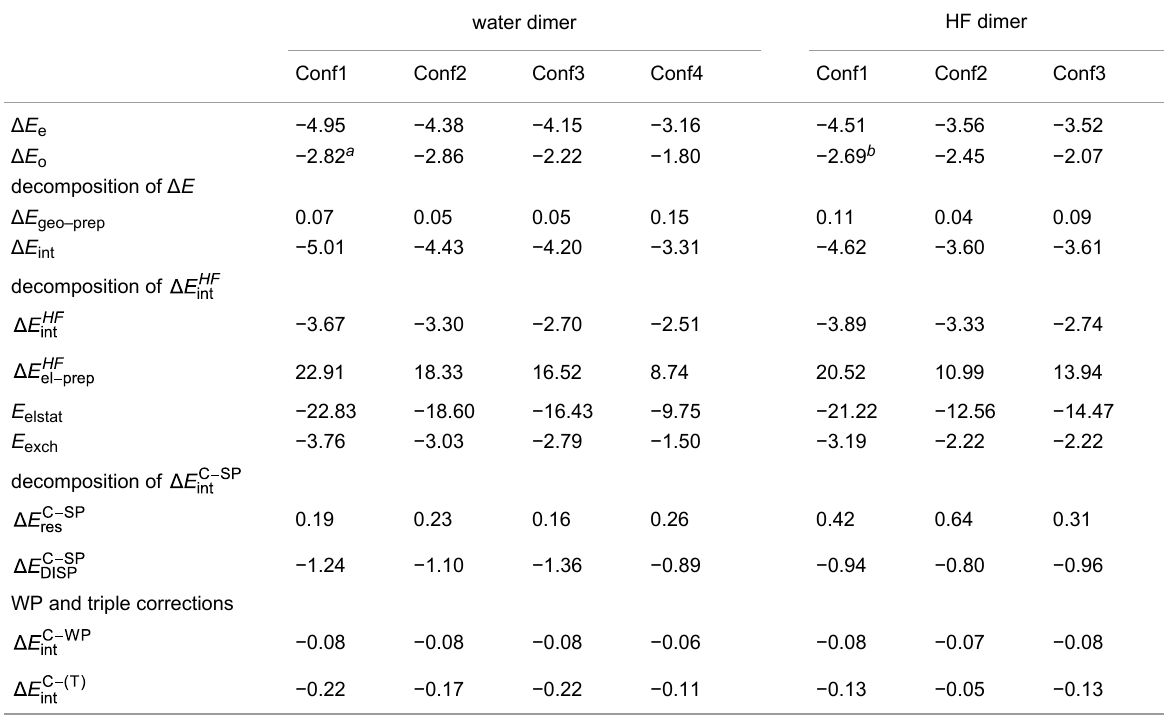
Table 1: The DLPNO-CCSD(T) dimerization energies (kcal/mol) of the conformers of water and HF dimers together with the individual LED terms.